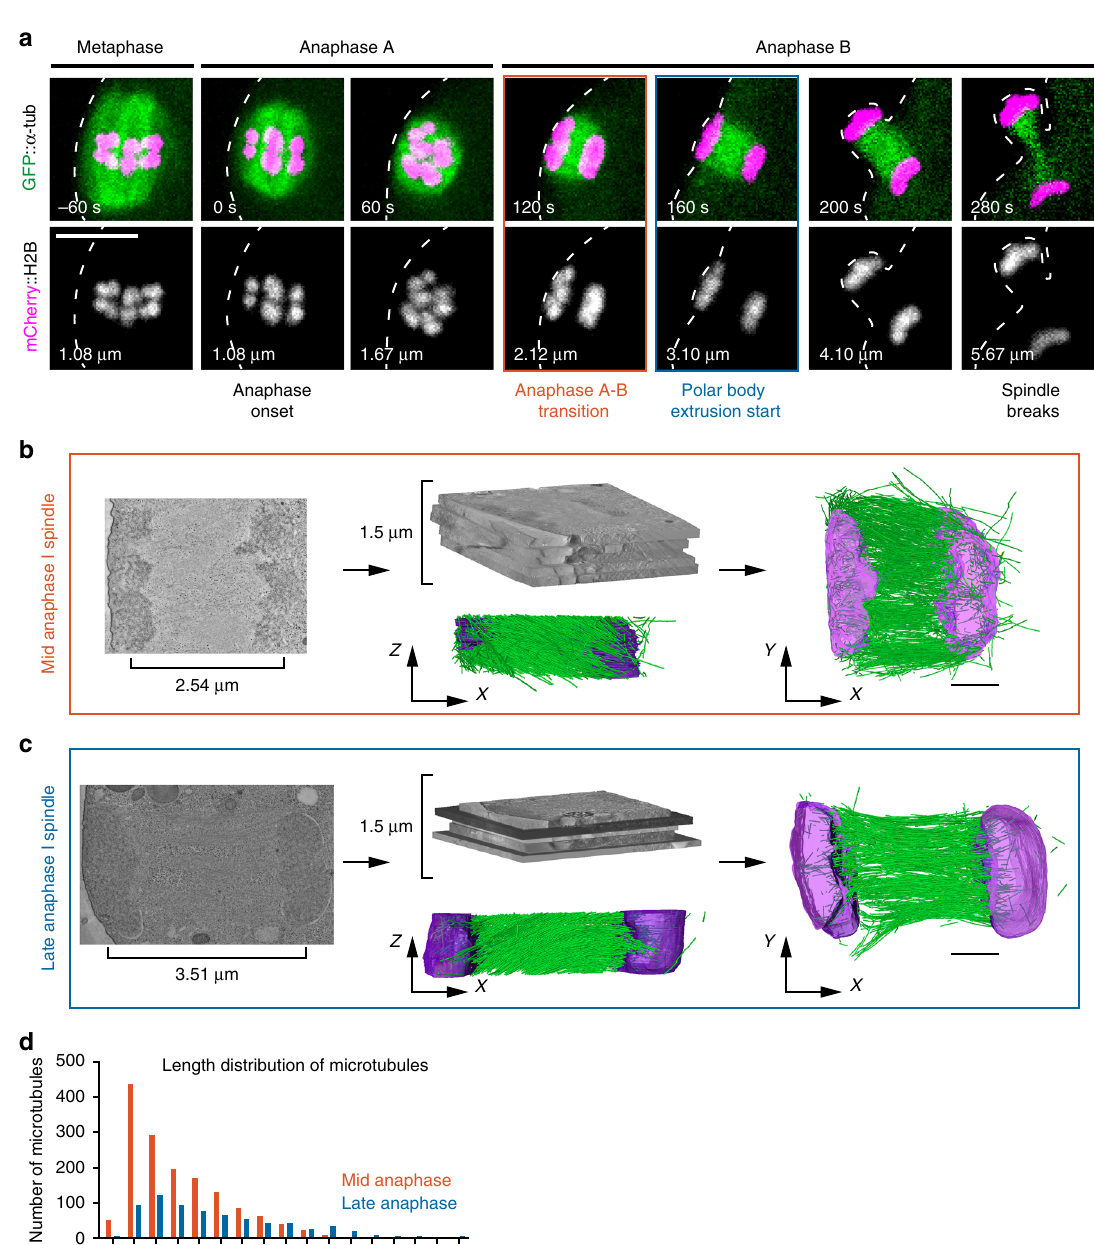
Fig. 1 Three-dimentional reconstructions of the anaphase meiotic spindle by electron tomography. a Still images from live imaging of a fertilized oocyte expressing GFP-tagged tubulin and mCherry-tagged histone H2B. Timing from anaphase onset and the distance between the centroid of each set of segregating chromosomes are indicated at the bottom left corner of each frame. The two meiotic stages used for spindle reconstruction by tomography are framed in red (mid-anaphase) or blue (late anaphase). Scale bar, 5 µ m. b , c Strategy used and partial spindle reconstructions for the mid- b and late c anaphase I spindle. (Left) XY plane image of the combined dual-axis tomogram. (Middle) Stitching of fi ve successive 300 nm-thick serial sections used to generate the combined tomogram and XZ projections of the fi nal reconstruction. Microtubules (green), chromosomes (magenta). (Right) XY -projected model of chromosomes (magenta) and microtubules (green). Scale bars, 1 µ m. d Length distribution of fully contained microtubules for mid- (red) and late (blue) spindle